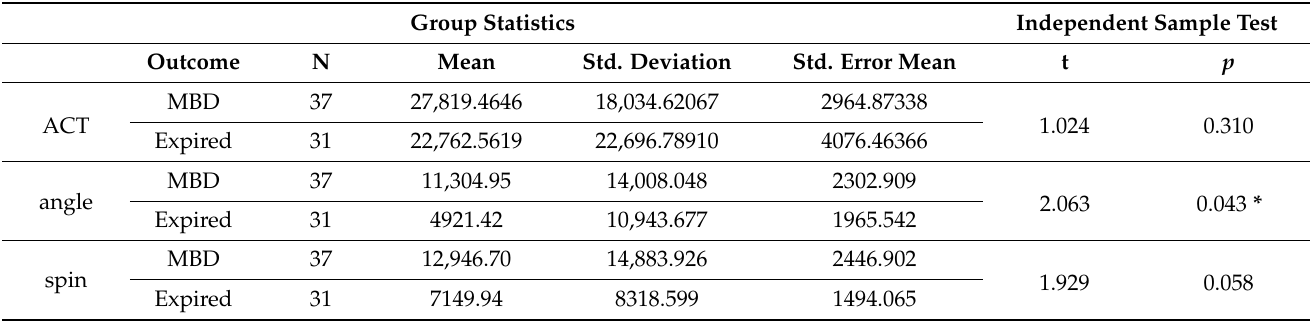
Table 3. Statistical difference in ACT, angle, and spin values for MBD and expired in 24 h data ( p < 0.05 is considered as significant *).